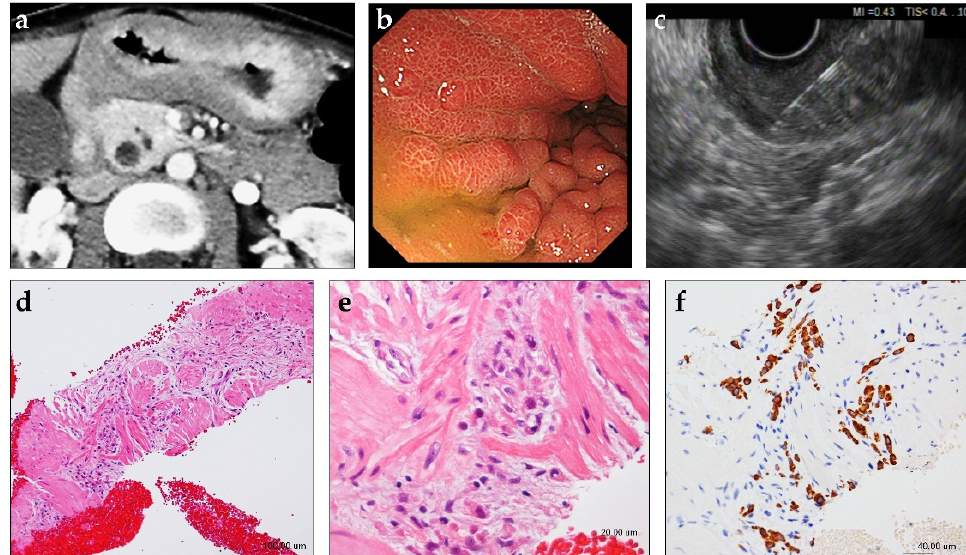
Figure 2. Case presentation of a patient with gastric linitis plastica in whom EUS-guided fine-needle biopsy (EUS-FNB) was useful for histological tissue sampling. A female patient in her 40s with abdominal pain and weight loss was referred to our hospital. ( a ) Contrast-enhanced computed tomography shows circumferential thickening of the gastric wall. ( b ) Upper endoscopy shows diffuse gastric wall thickening and large gastric folds. No ulceration is observed. Evaluation of multiple biopsies collected from the thickened gastric wall did not reveal evidence of malignancy. ( c ) On EUS, the thickened gastric wall is visualized as a 20-mm-thick, diffusely hypoechoic area with loss of normal layer definition. EUS-FNB of the thickened gastric wall was performed using a 22-gauge Franseen-tip core biopsy needle. ( d , e ) Histological diagnosis of the specimen collected by EUS-FNB showing a cluster of poorly differentiated adenocarcinoma within the muscularis propria of the gastric wall (hematoxylin/eosin staining). ( f ) Additional immunohistochemical analyses reveal that the tumor cells are positive for keratin AE1/AE3. Table 2. Characteristics and outcomes of patients with GLP who underwent EUS-guided fine-needle aspiration biopsy following negative endoscopic biopsy ( n = 13).